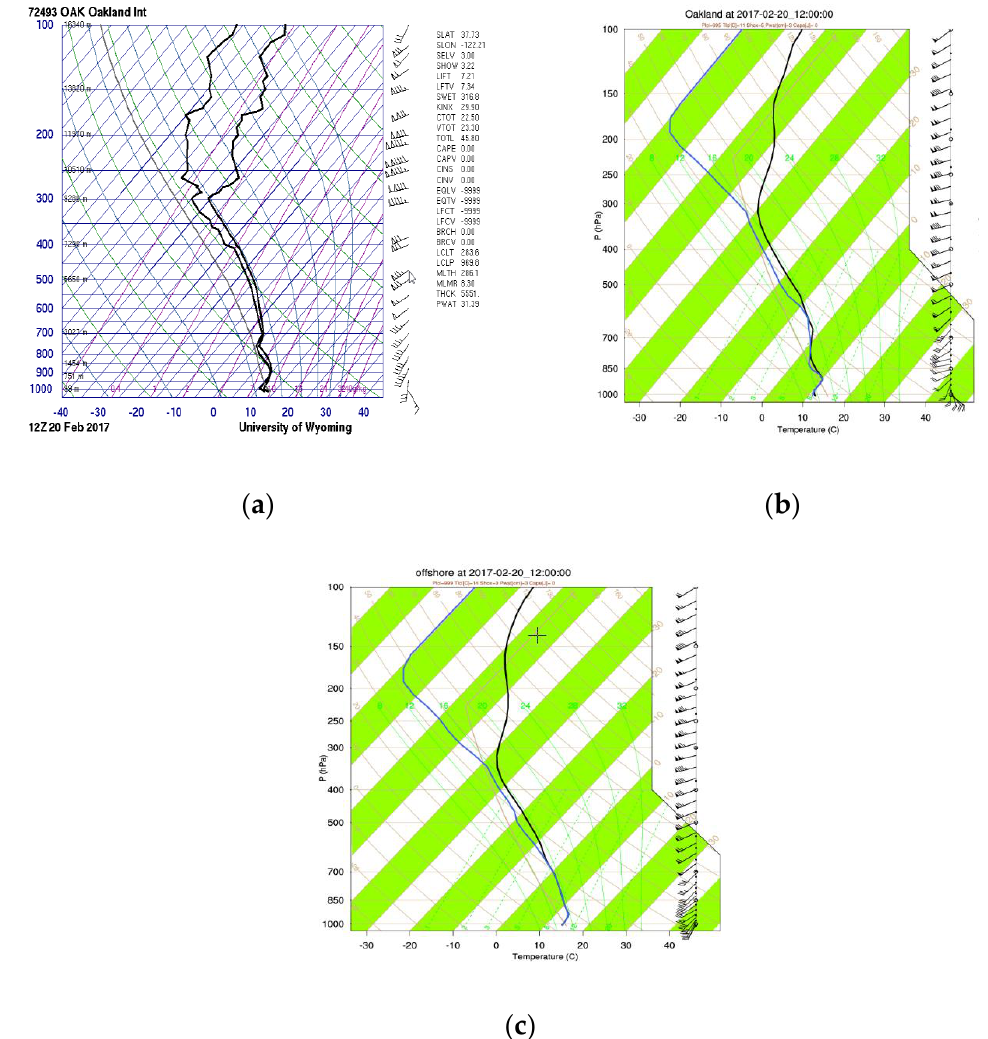
Figure 7. ( a ) observed radiosonde sounding at Oakland (KOAK) at 12Z on 20 February 2017; ( b ) WRF-simulated sounding at gridpoint closest to OAK at same time; ( c ) Same as ( b ), but at a gridpoint to the southwest of Oakland over the ocean (away from local terrain